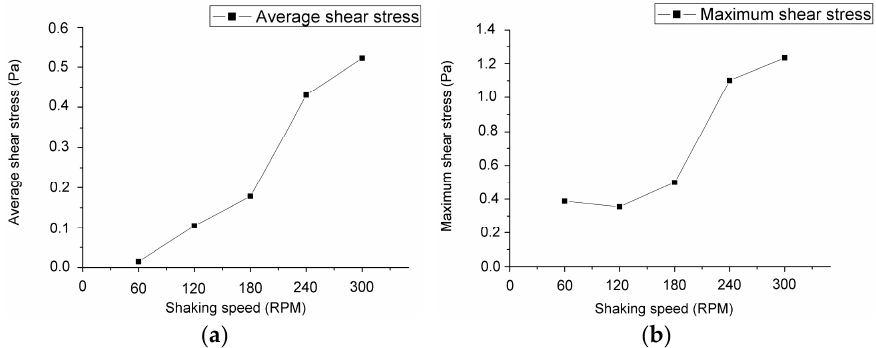
Figure 9. The variation of ( a ) the average shear stress and ( b ) the maximum shear stress along the specific diameter defined in Figure 3 on the bottom surface of the container with five rotating speeds. (Rotating diameter = 1 cm and container’s diameter = 3 cm)